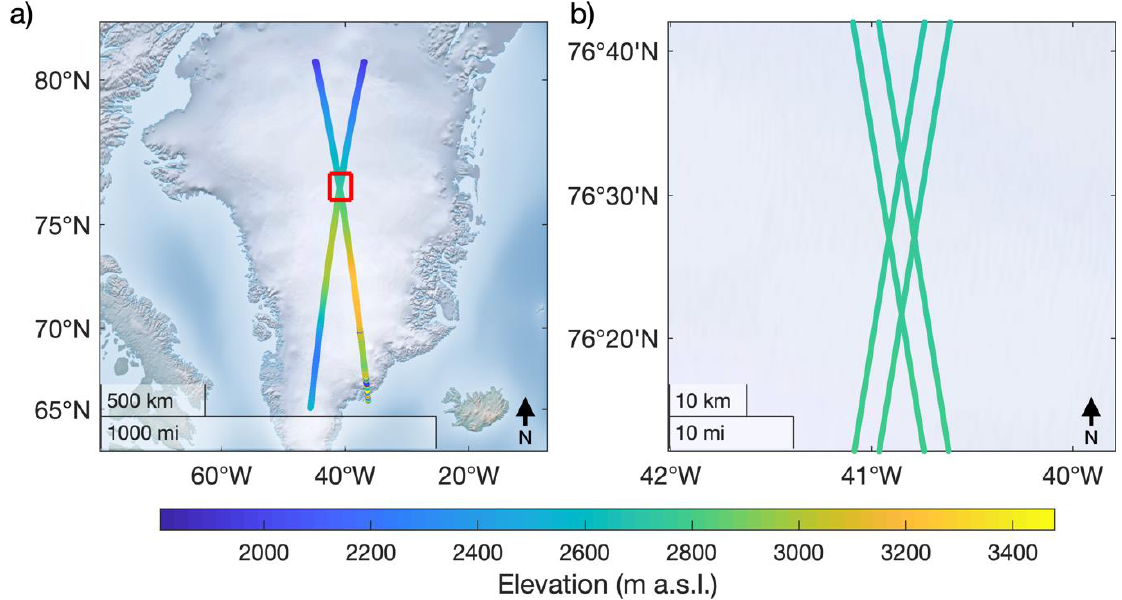
Figure 4. ( a ) Example of ATLAS/ICESat-2 Level-3A data product Land Ice Height, Version 1 (ATL06), representing 304,550 unique surface elevation measurements collected on 18 October 2018 [178]; ( b ) example crossover location (red box inset in (a)) showing the ICESat-2 multi-beam configuration (two beam-pairs shown, the third beam-pair was not included in ATL06 Version 1 at this time and location). Single-beam altimeters such as ICESat give one crossover measurement at each crossover location, and the cross-track slope cannot be determined in the along-track direction. The ICESat-2 multi-beam configuration allows determination of cross-track slope and gives multiple unique crossover measurements at each crossover location (up to nine possible, four shown in this example).